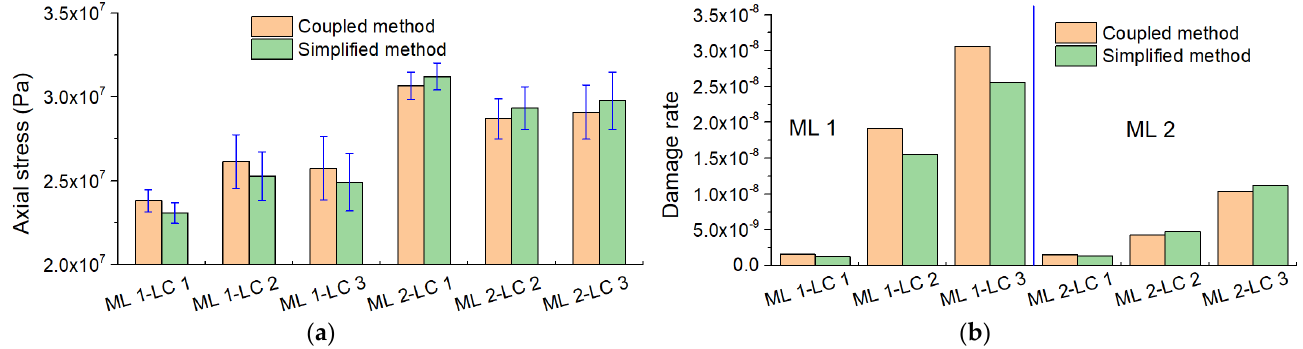
Figure 16. Fatigue plot of mooring line under different load cases: ( a ) Axial stress; ( b ) Damage rate.